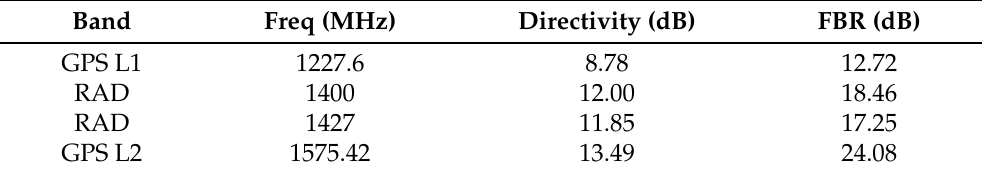
Table 12. Cubic cup ground plane with structure